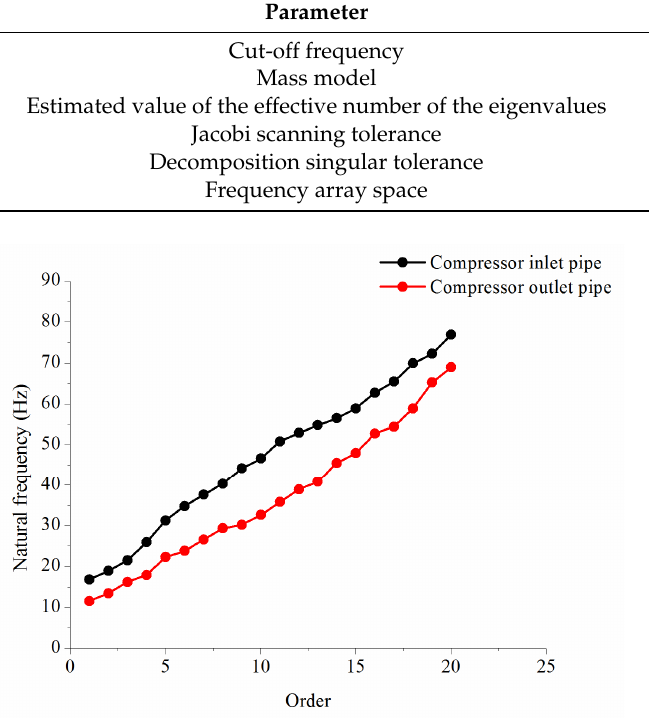
Figure 13. Natural frequency of compressor inlet pipe and outlet pipe.